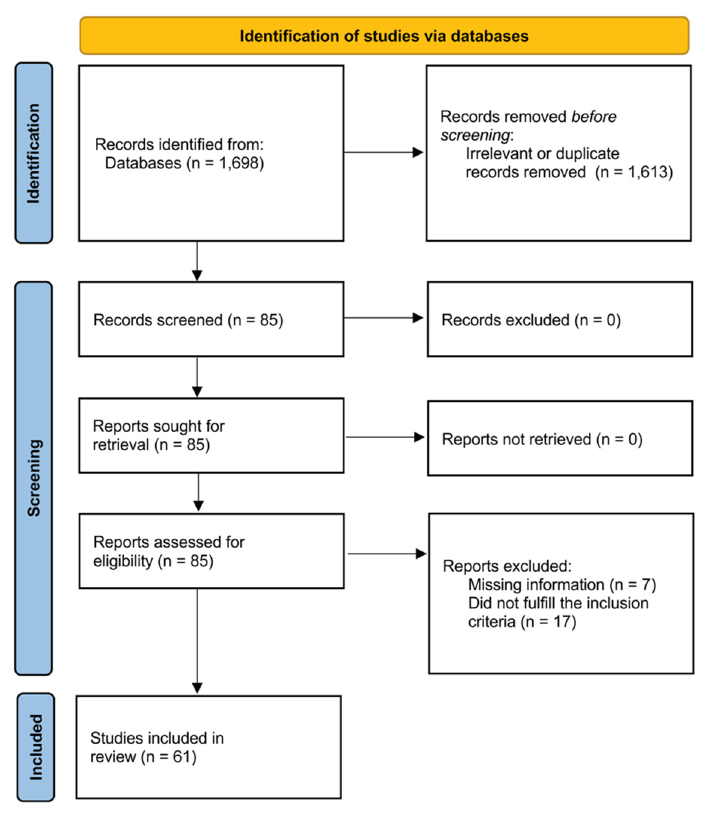
Figure 1. PRISMA 2020 flow chart.